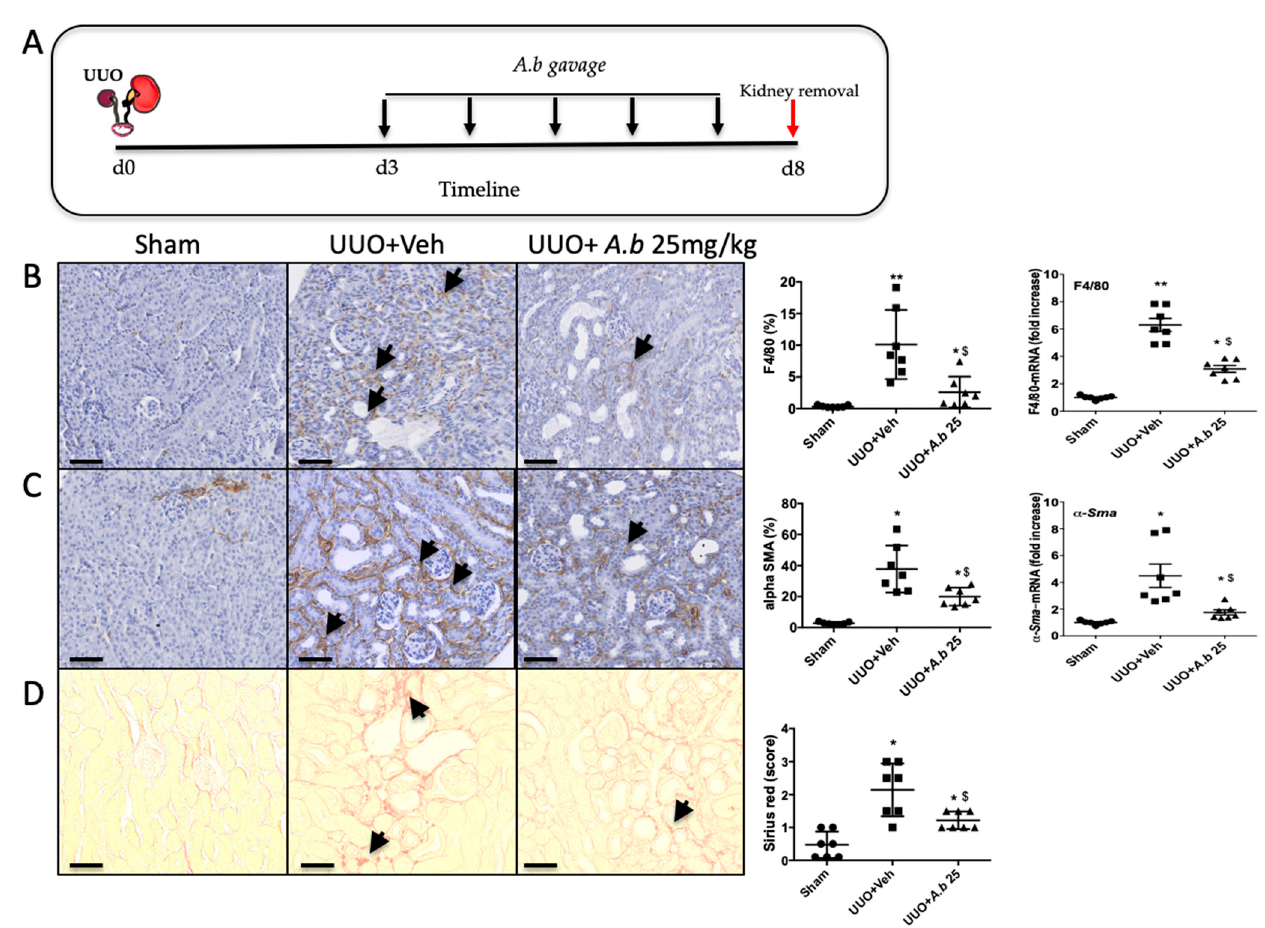
Figure 3. Curative effect of A. borbonica ( A. b ) 25 mg/kg on renal tubulointerstitial fibrosis induced by unilateral ureteral obstruction (UUO) in mice. ( A ) Experiment design: the black arrows indicate daily gavage with A. b. ( B ) Macrophage infiltration revealed by F4/80 immunostaining, arrows indicate macrophages. ( C ) Accumulation of myofibroblasts revealed by alpha SMA staining, arrows indicate myofibroblasts. ( D ) Renal tubulointerstitial fibrosis shown by Sirius red staining, arrows indicate interstitial fibrosis. Sham-operated group (Sham), unilateral ureteral obstruction group receiving vehicle (UUO + Veh) and unilateral ureteral obstruction group receiving polyphenol-rich extract from A. b (UUO + A. b 25 mg/kg). For each staining, quantitative results are shown on the right part of the figure (scatter dot plot), as well as renal mRNA expression of F4/80 and α -Sma ; n = 7 per group. * p < 0.05, ** p < 0.01, compared to Sham; $ p < 0.05 compared to UUO + Veh. Scale bar = 100 µ